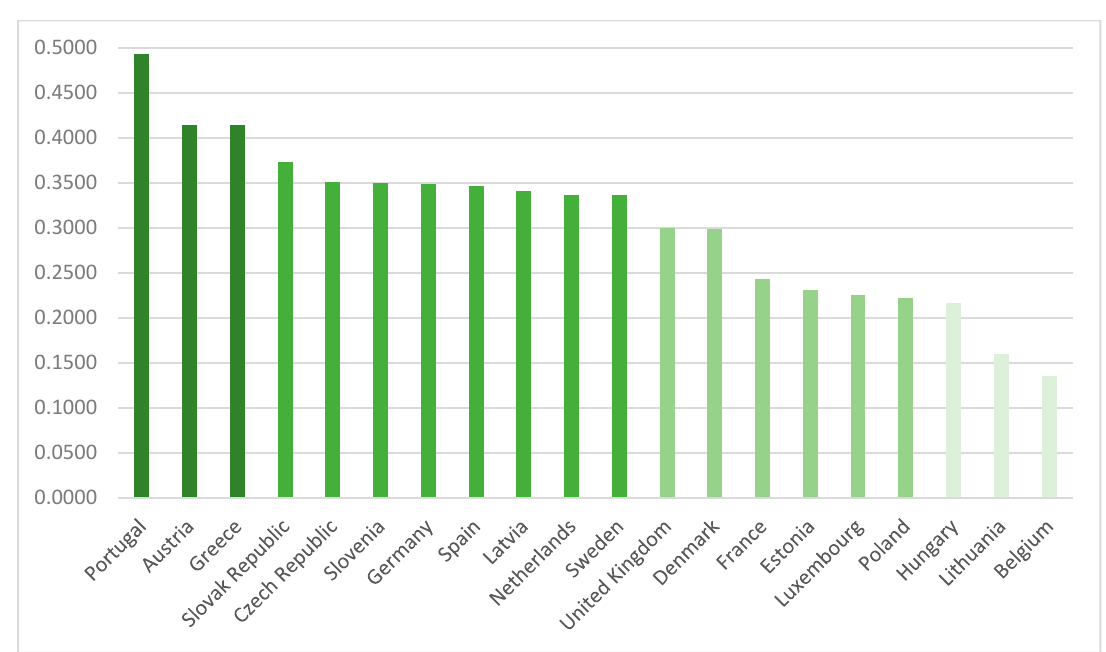
Figure 1. Ranking of selected EU countries based on AEI .